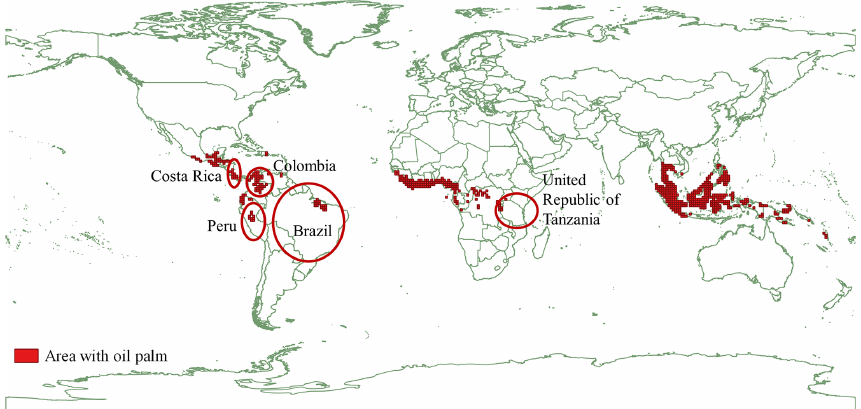
Figure A1. The global distribution of oil palm according to Descals et al. (2020). The five countries for which we validated our datasets are circled in red.